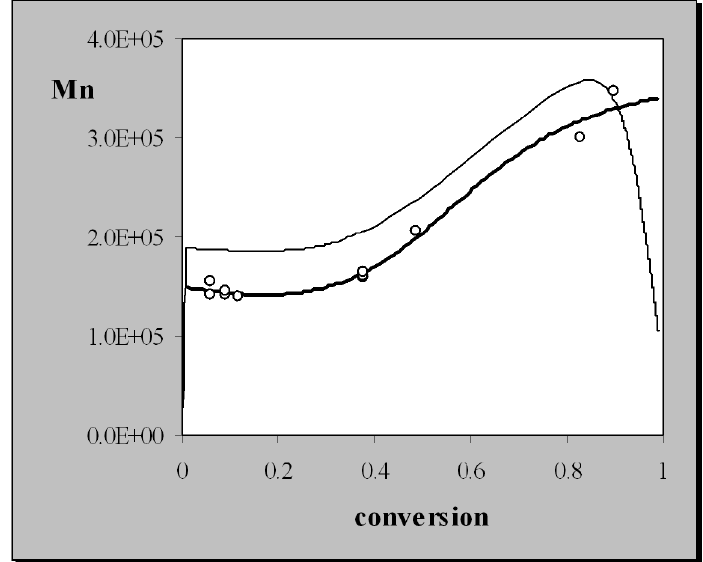
Fig. 9 Number average molecular weight obtained with MLP (3:8:1)(thick line), by simulation on the kinetic model (thin line) and experimentally (o) [15], [16] at 70 o C and 15.48 mol/m 3 .